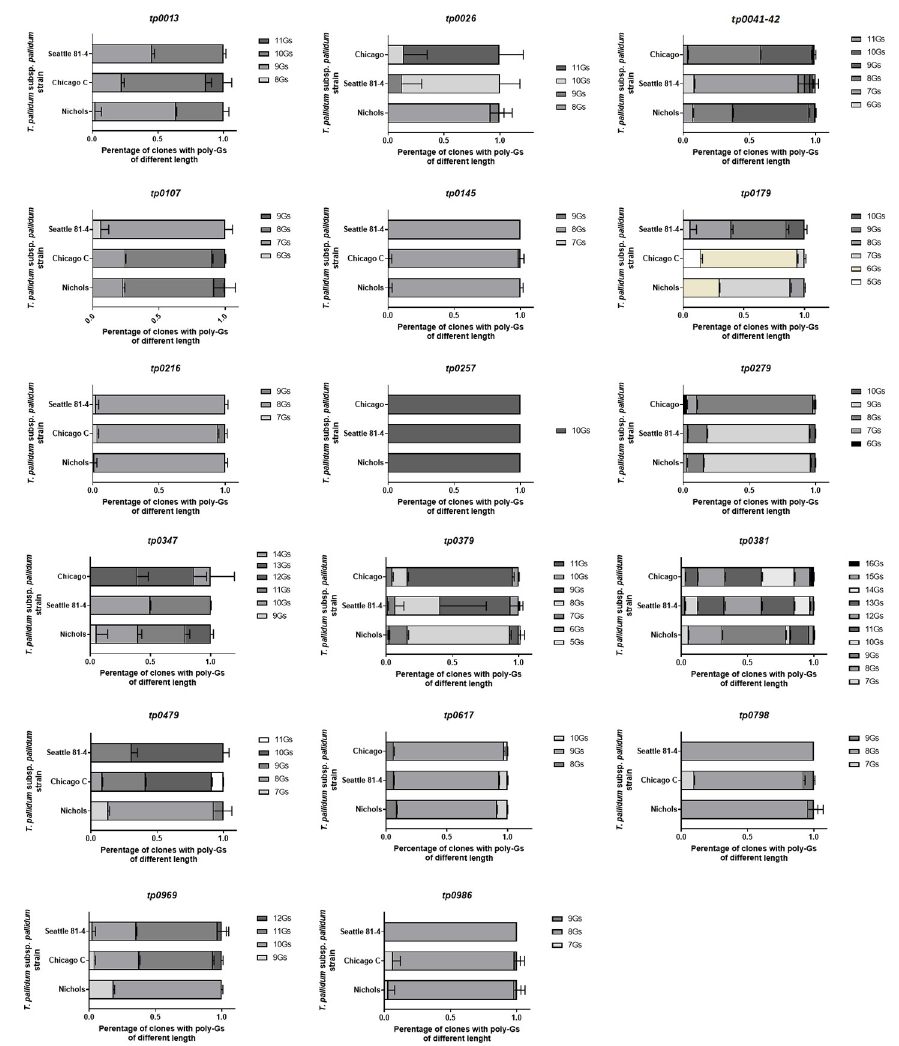
Fig 5. Analysis of poly-G tracts not already studied found throughout the T . p . pallidum genome. Because human treponematoses spirochetes have GC-rich genomes (~52.8%), and poly-G tracts are common, we only selected those showing an initial length � 8